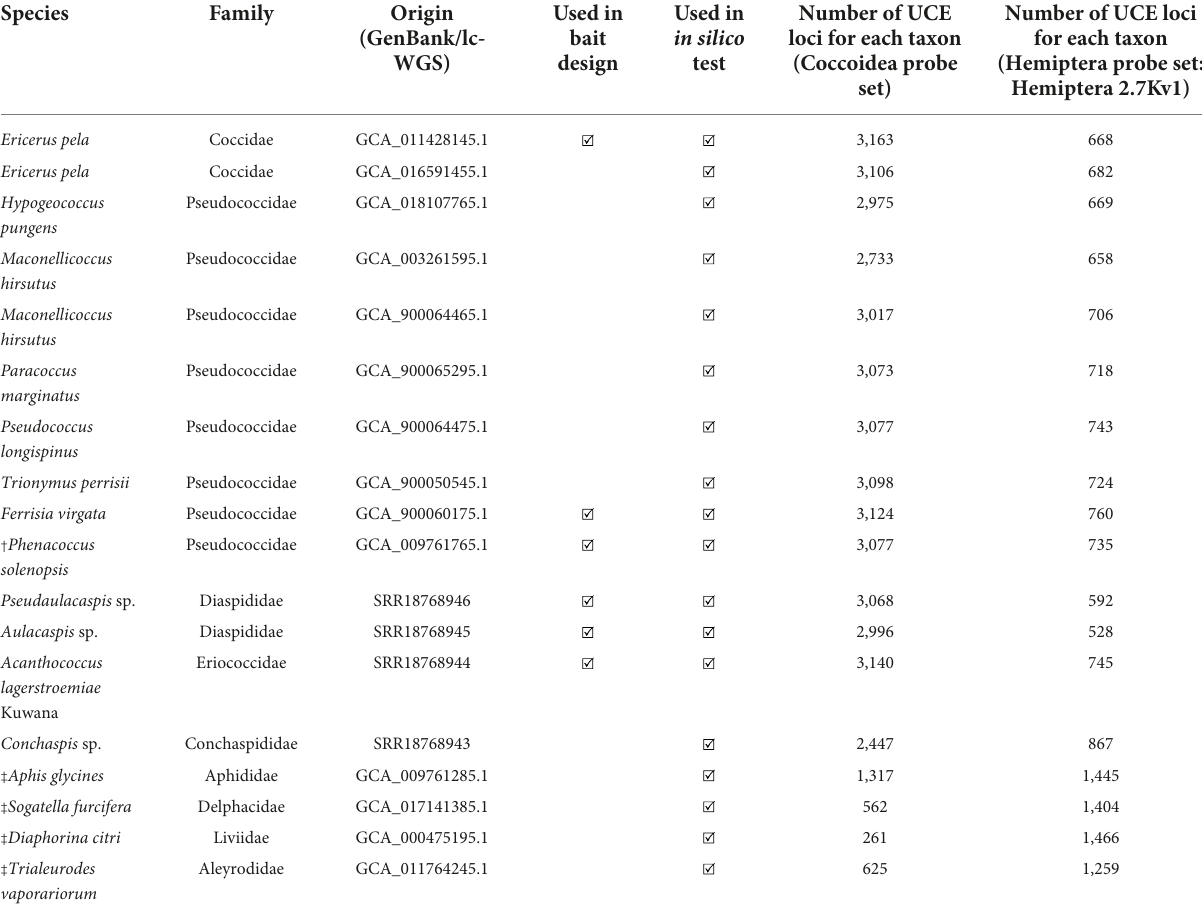
TABLE 1 Study group used in current